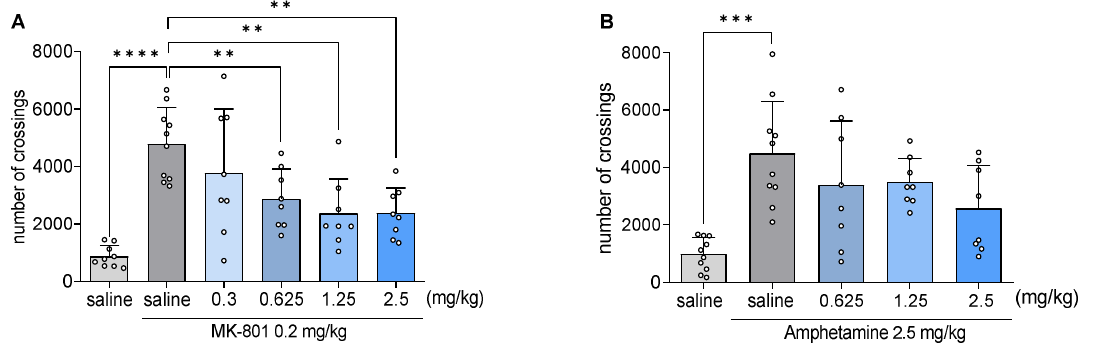
Figure 3. The effect of JJGW07 on the MK-801-induced (Panel ( A )) and amphetamine-induced (Panel ( B )) hyperlocomotion in mice. Locomotor activity was recorded in actometers separately for each mouse. After 30 min of adaptation, the number of crossings of photobeams was measured during 60 min. JJGW07 was administered intraperitoneally ( ip ) 30 min before the test. MK-801 (0.2 mg/kg, ip ) was administered 15 min before the experiment, while amphetamine (2.5 mg/kg) was administered subcutaneously ( sc ) 30 min before the experiment. The control groups received either two injections of 0.9% NaCl ( ip or sc ), or 0.9% NaCl (ip) and MK-801 ( ip ), or 0.9% NaCl (ip) and amphetamine ( sc ). Values are expressed as means ± SD; n = 8–10 mice per group. Statistical analysis: one-way ANOVA (Newman–Keuls post hoc); ** p < 0.01, *** p < 0.001, **** p < 0.0001.